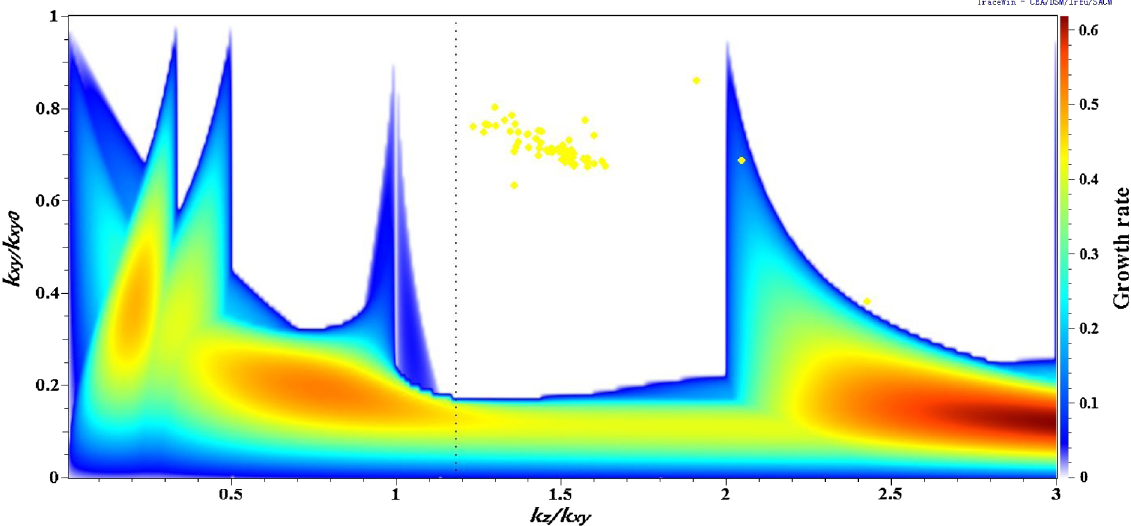
FIG. 16. Tune footprint in the Hofmann chart for the main linac. Growth rates are in units of zero space-charge betatron tune.